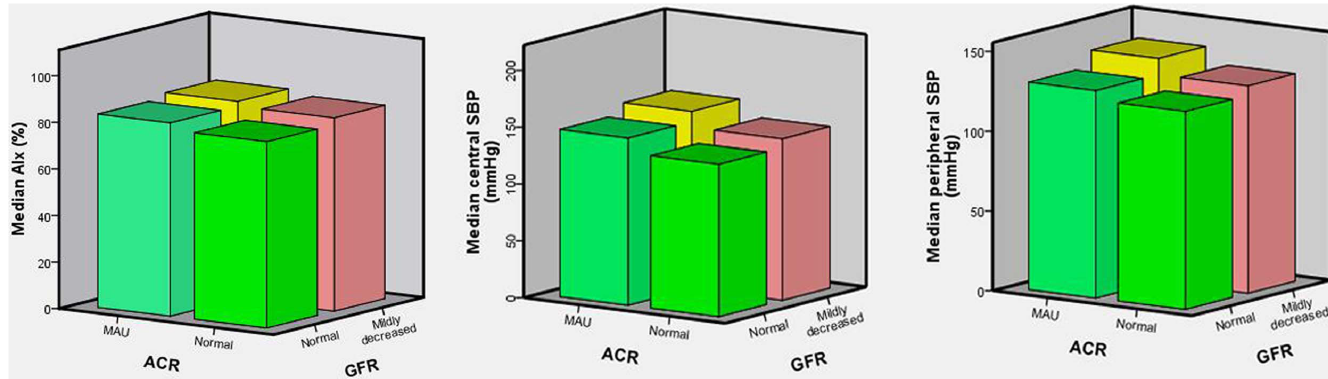
Figure 1. AIx and BP of the study population categorized into 4 subgroups based on the presence or absence (normal GFR) of mildly decreased GFR and the presence or absence (normal ACR) of MAU. The difference between subgroups was highly significant (all p , 0.001). Abbreviation : AIx: augmentation index; BP: blood pressure; GFR: glomerular filtration rate; ACR: albumin-to-creatinine ratio; MAU: microalbuminuria; SBP: systolic blood pressure.